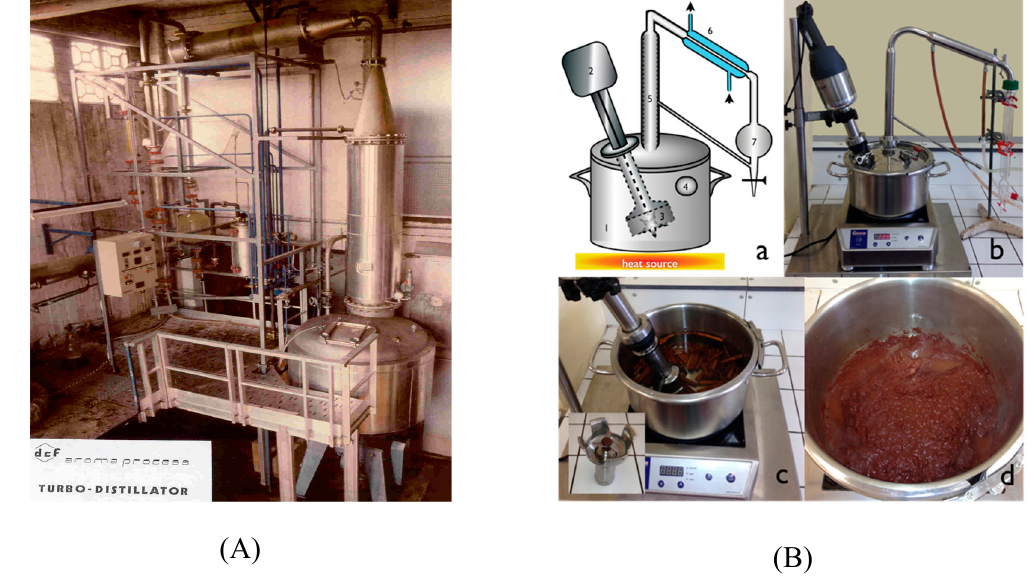
Figure 3. ( A ) Industrial turbo-Clevenger; ( B ) laboratory turbo-Clevenger: ( a ) schematic, ( b ) bench apparatus, ( c ) cinnamon experiment before extraction with mixer detail (insert), ( d ) cinnamon experiment after extraction.